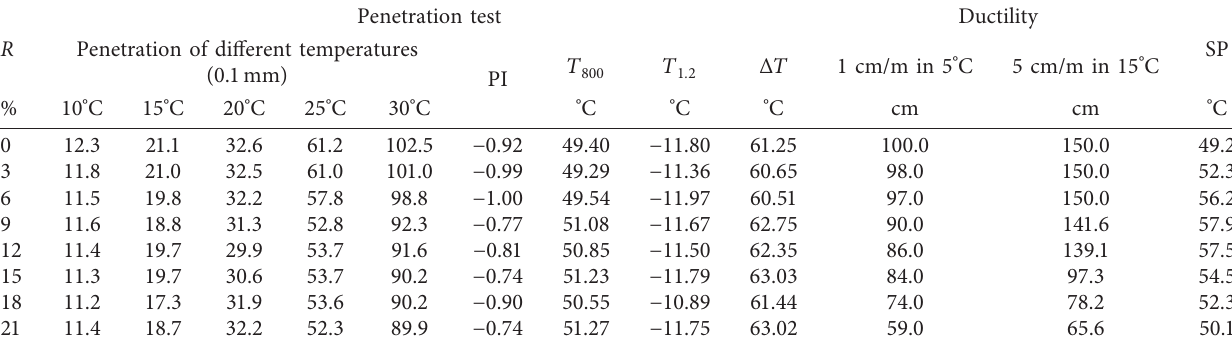
Table 3: Summary table of the test results of three